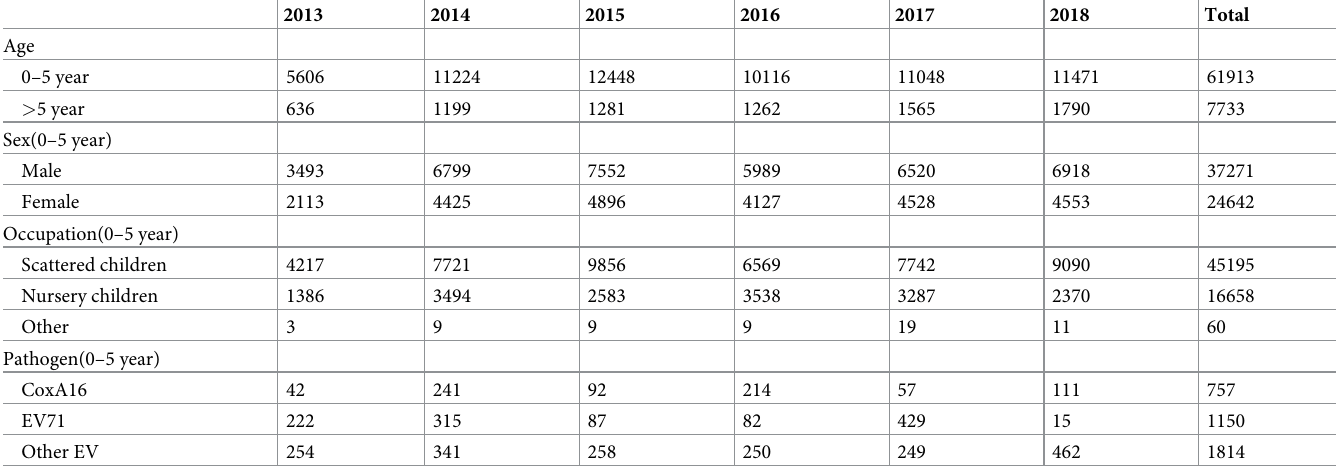
Table 1. Demographic characteristic of HFMD cases and the pathogen types of some cases in Qingdao City,